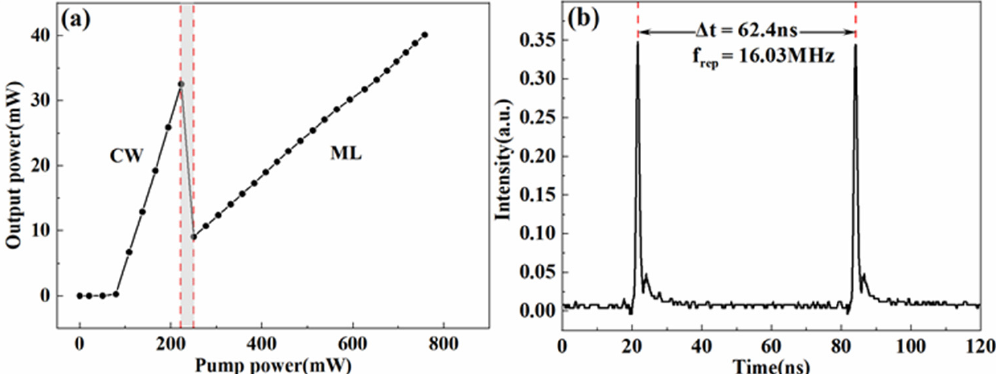
Figure 2. ( a ) Experimentally measured output powers with respect to different pump powers. CW: continuous wave; ML: mode-locking. ( b ) The pulse train generated from the fiber oscillator.